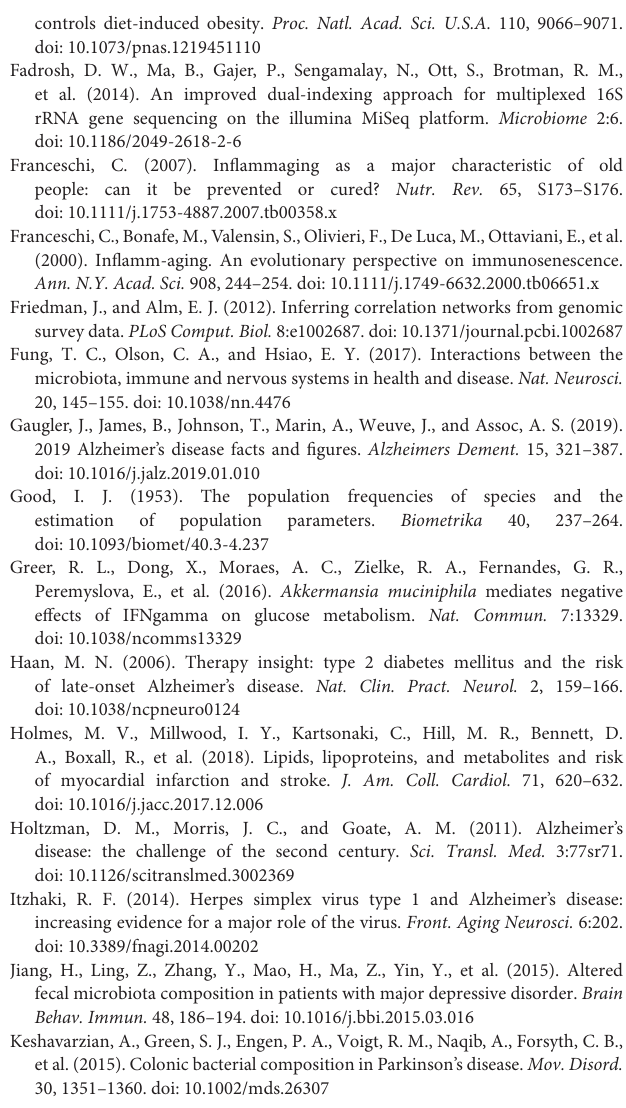
phyla in AD patients ( n = 100) and healthy controls ( n = 71).